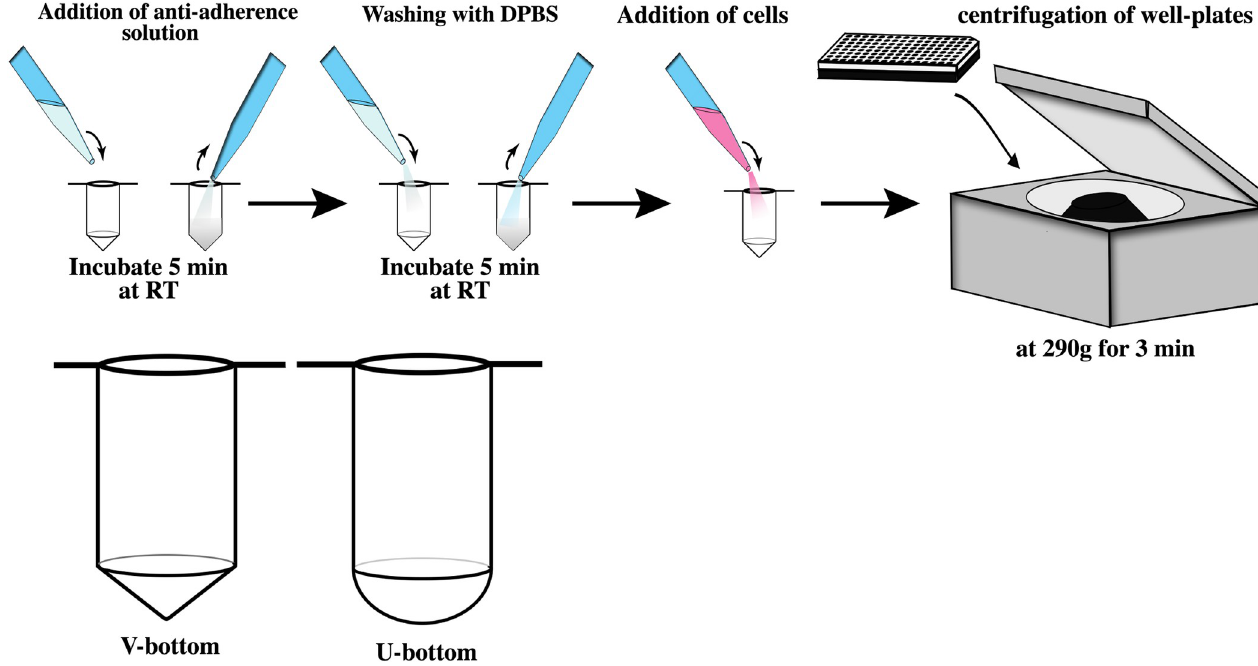
Fig 1. Protocol for embryoid body formation and different well geometries. We added anti-adherence solution into regular U- and V-bottom wells and incubated for 5 minutes at room temperature to develop anti-adherence coated plates and then washed gently with PBS. The application of an anti-adherence solution to conventional V-bottom and U-bottom plates enabled reproducible EB generation in low-cost well plates.